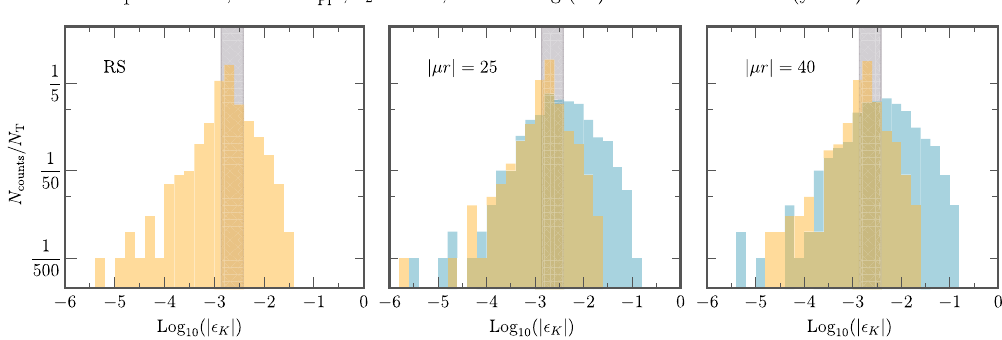
Figure 12 . Histogram showing the values of for µr = 25 and 40, both in the case of zero and strong backreaction (blue and yellow bins | | respectively). In all these figures we fix F 2 = 10 − 2 and m g